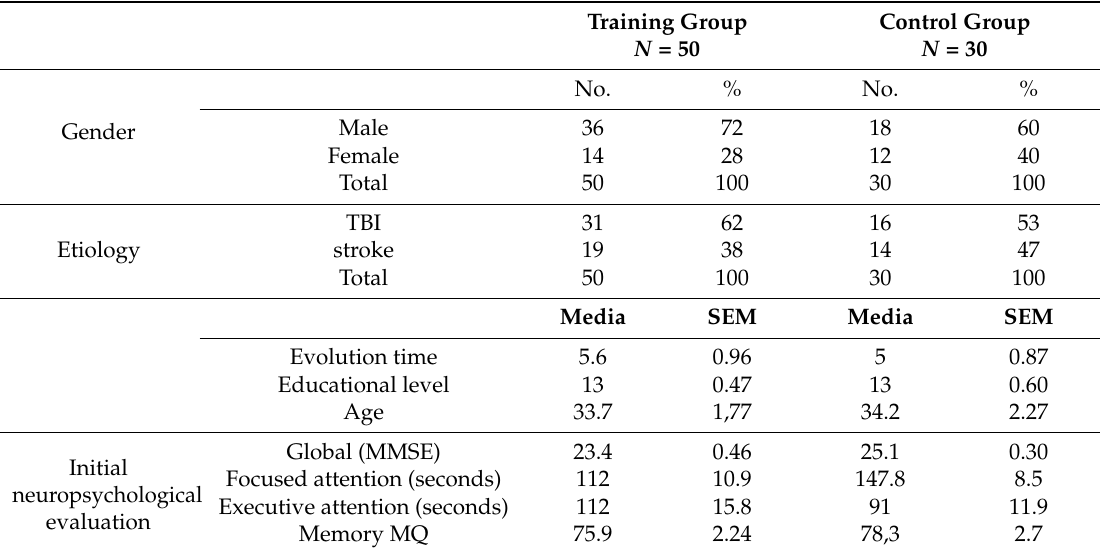
Table 1. Description of the sample included in the